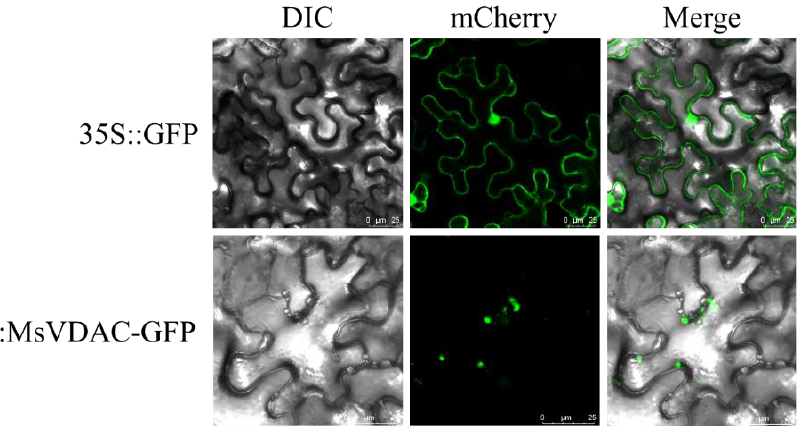
Figure 1. Subcellular localization of MsVDAC . The recombinant vector MsVDAC-GFP and 35S:GFP control vector were transferred into epidermal cells of N. benthamiana leaves. Scale bar, 25 µm.